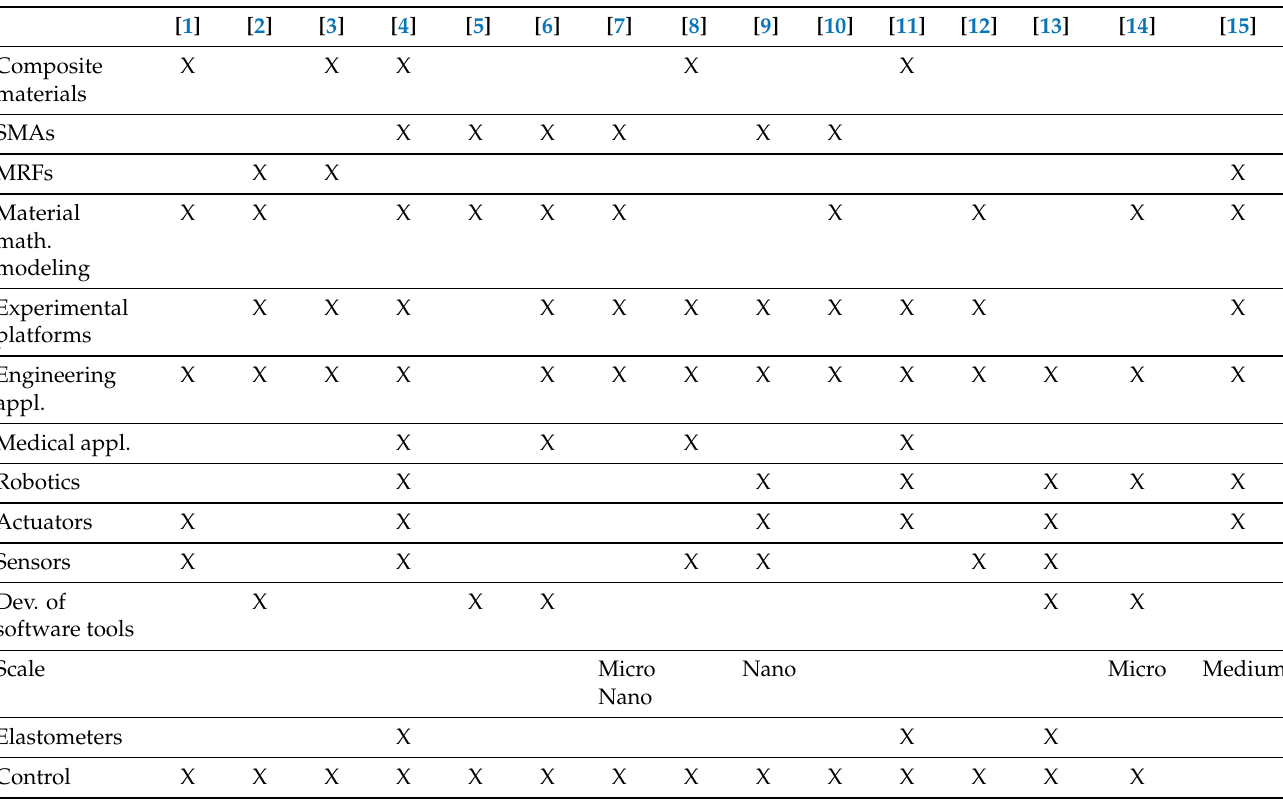
Table 1. Correlation matrix of the selected key